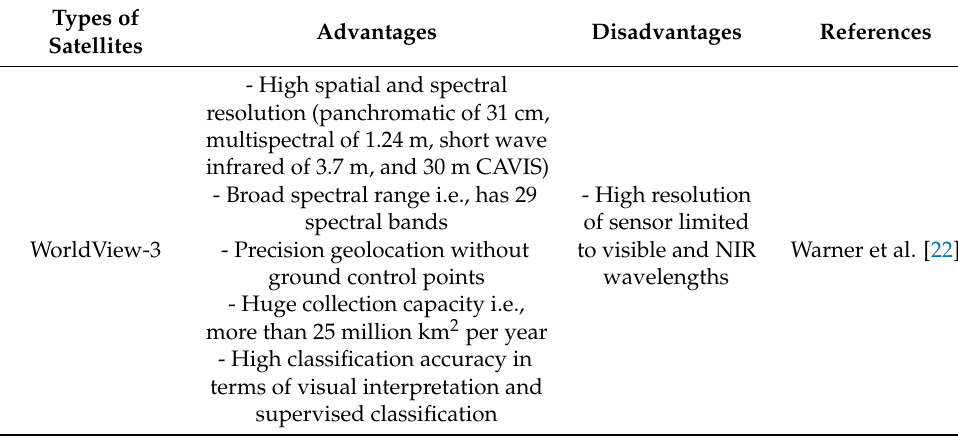
Table 1. Advantages and disadvantages of different satellite